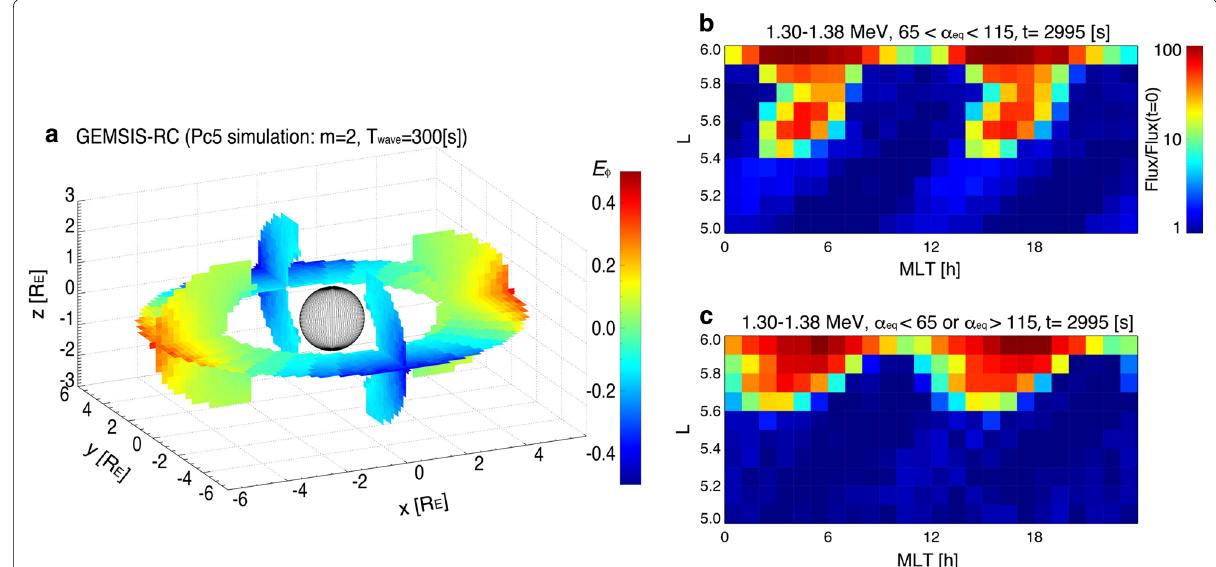
Fig. 7 a Spatial distribution of the poloidal electric field ( E φ ) in the inner magnetosphere obtained in the monochromatic Pc5 simulation with the wave period of 300 s and the azimuthal wave number of 2. Time evolution of the electric and magnetic fields in the Pc5 simulation is used as input to the GEMSIS‑RB simulation. b , c The resultant radial transport of relativistic electrons with a perpendicular and b oblique equatorial pitch angles after 10 Pc5 wave